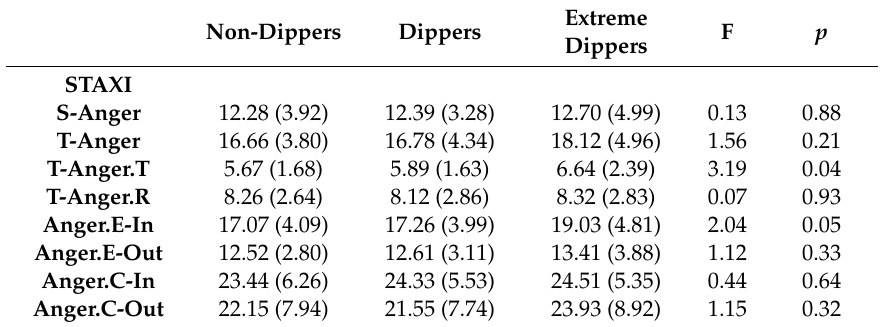
Table 3. Means ( ± SD) of anger scores and ANOVA results for the three groups of participants. Non-Dippers